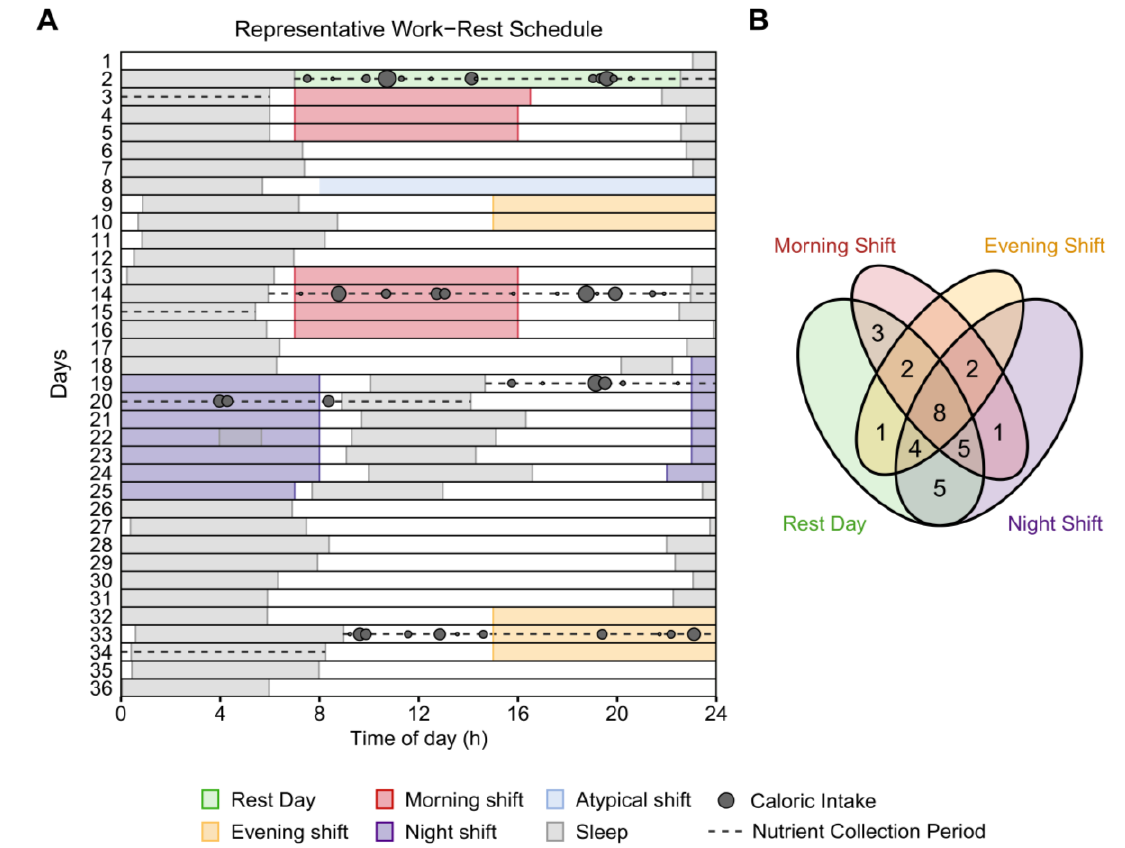
Figure 1. Raster plot of the study schedule and Venn diagram of day type contributions. ( A ) Diagram of the work–rest schedule, sleep–wake patterns, and eating behavior of one participant on a 35-day cycle. Successive study days are depicted on the vertical axis and time-of-day along the abscissa. Grey rectangles depict sleep episodes and colored rectangles represent shifts. Dashed horizontal lines identify the relevant nutrient collection periods for each “day type” (from top to bottom: rest, morning-shift, night-shift, and evening-shift days)—beginning from the wake time of the main sleep period prior to each shift/rest day until the wake time of the following main sleep period. Grey circles represent caloric intakes of different sizes. ( B ) Venn diagram of the number of participants contributing to each combination of day types. Of the 31 participants, 8 contributed to all 4 possible day types, 21 contributed to at least 3 day types, and all 31 contributed to at least 2 day types.